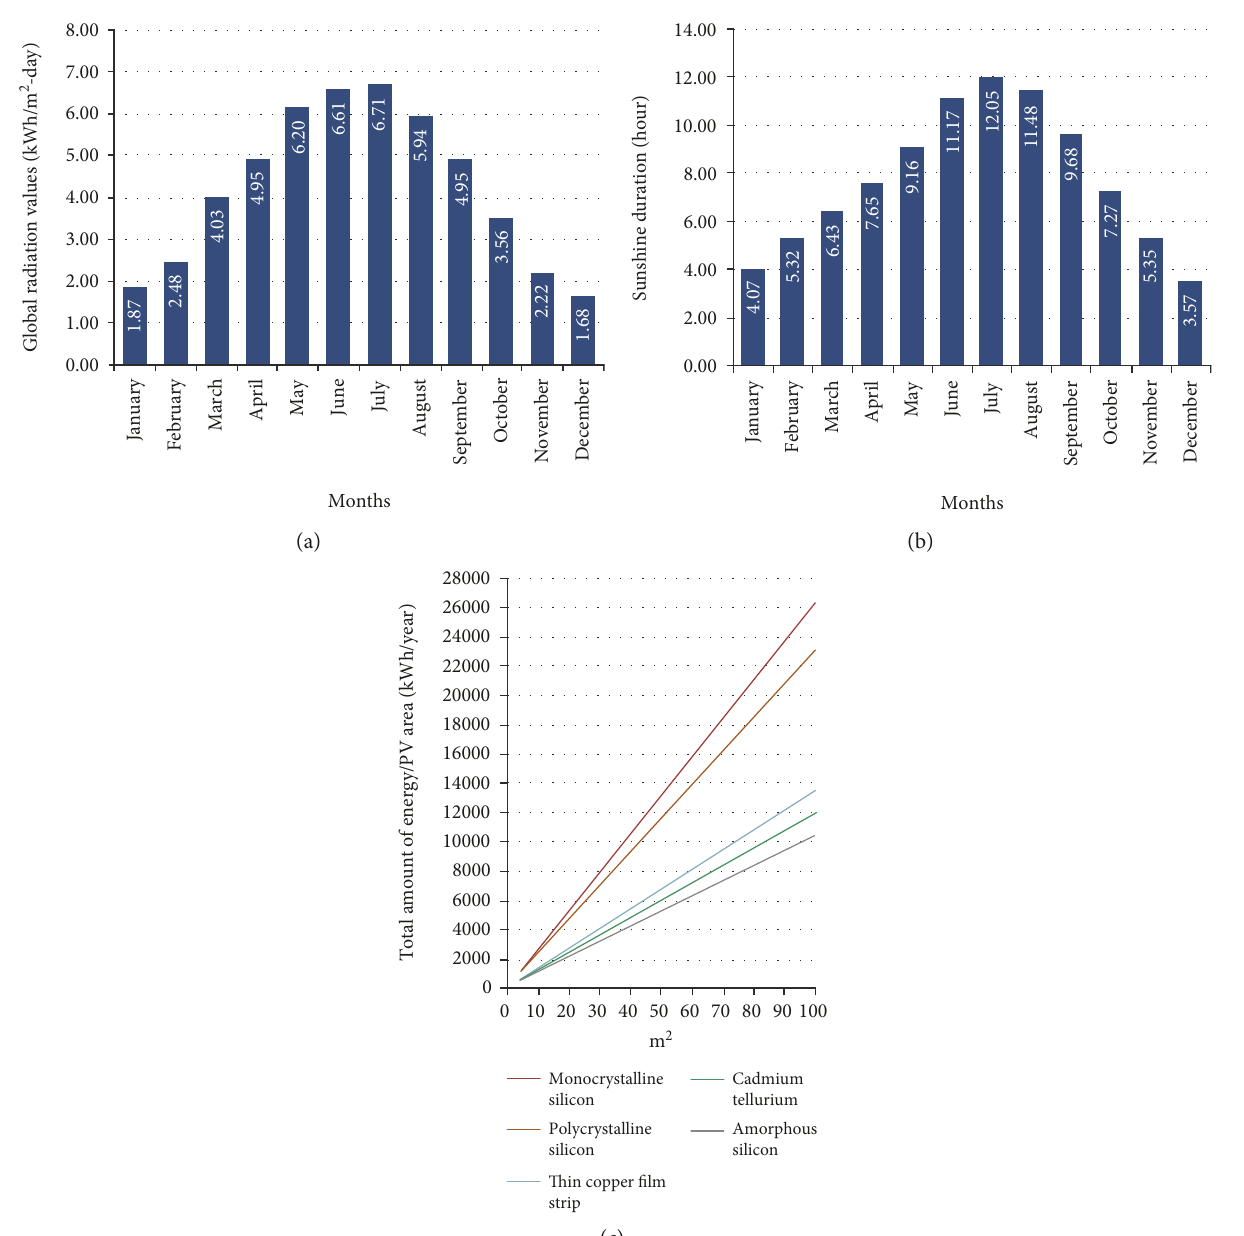
Figure 4: Nev ş ehir province (a) global radiation values, (b) sunshine duration, and (c) total amount of energy/PV